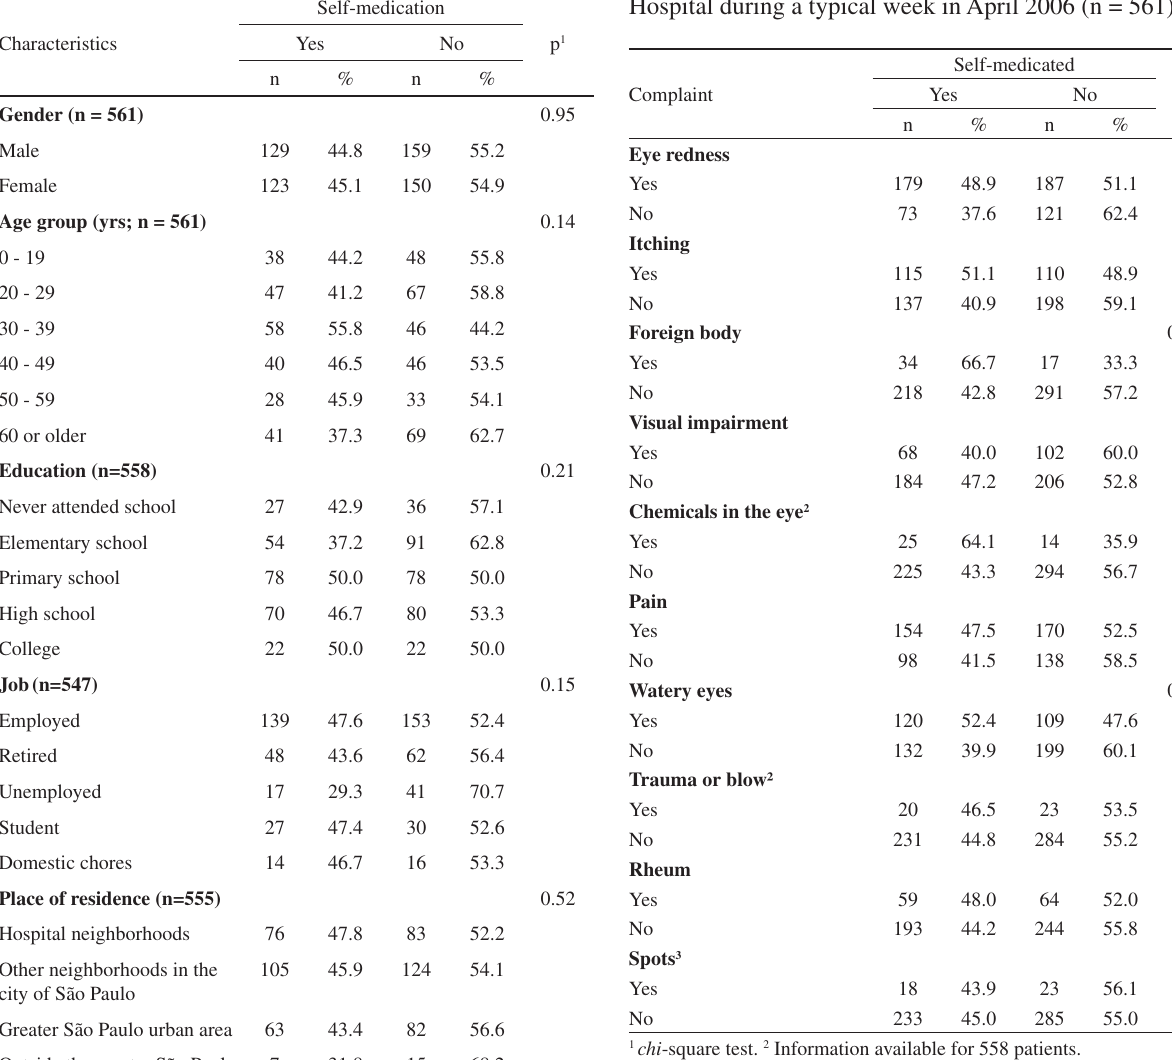
1 chi -square test. 2 Information available for 558 patients. 3 Information available for 559 patients